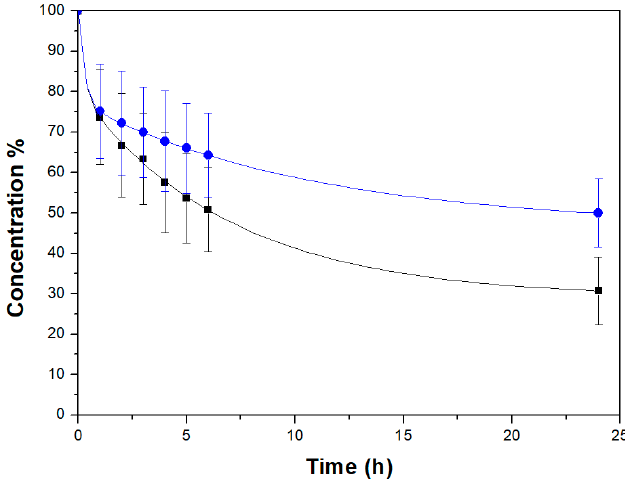
Figure 6. Concentration (%) decrease over time of 1.5 × 10 − 2 mM Rhodamine B water solution in the presence of calcined Mono-ICE before ( (cid:4) ) and after water treatment ( • ). Error bars represent standard deviations calculated on averaging results collected from three replicated experiments.